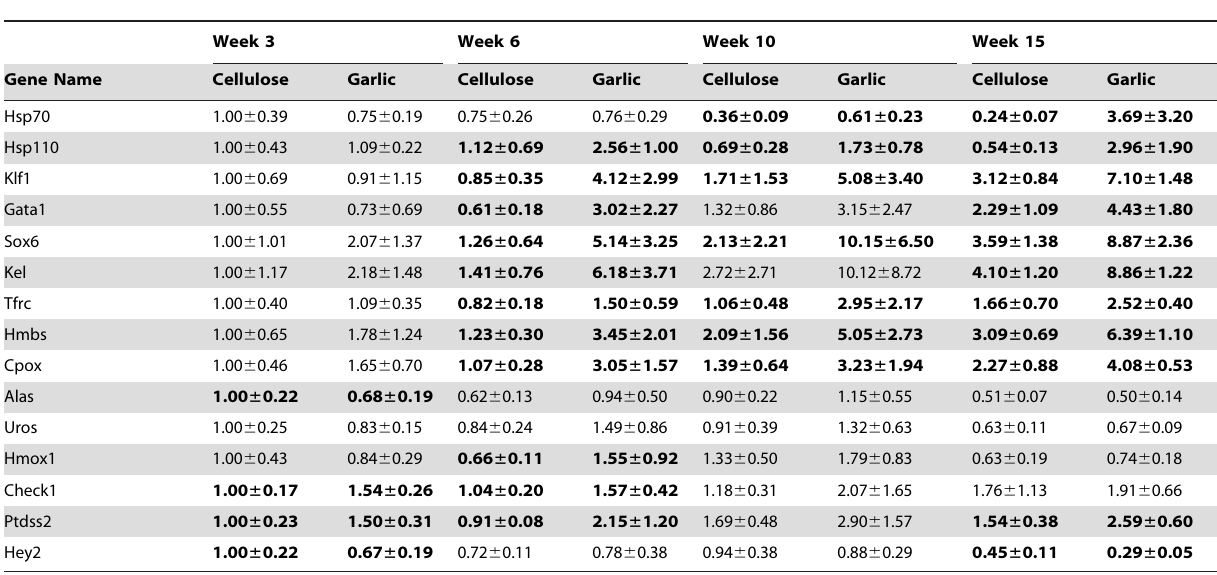
Table 1. QPCR analyses of selected genes in mouse spleens (n=